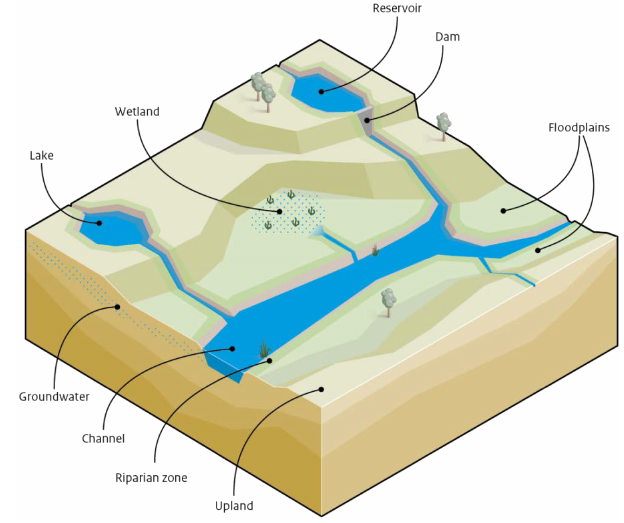
Figure 4. Scheme of the routing of water (with N and P) in a land- scape with streams, rivers, lakes, wetlands and reservoirs; each type of water body within a grid cell is defined by an inflow or discharge, depth and area. Floodplains may be temporarily or permanently